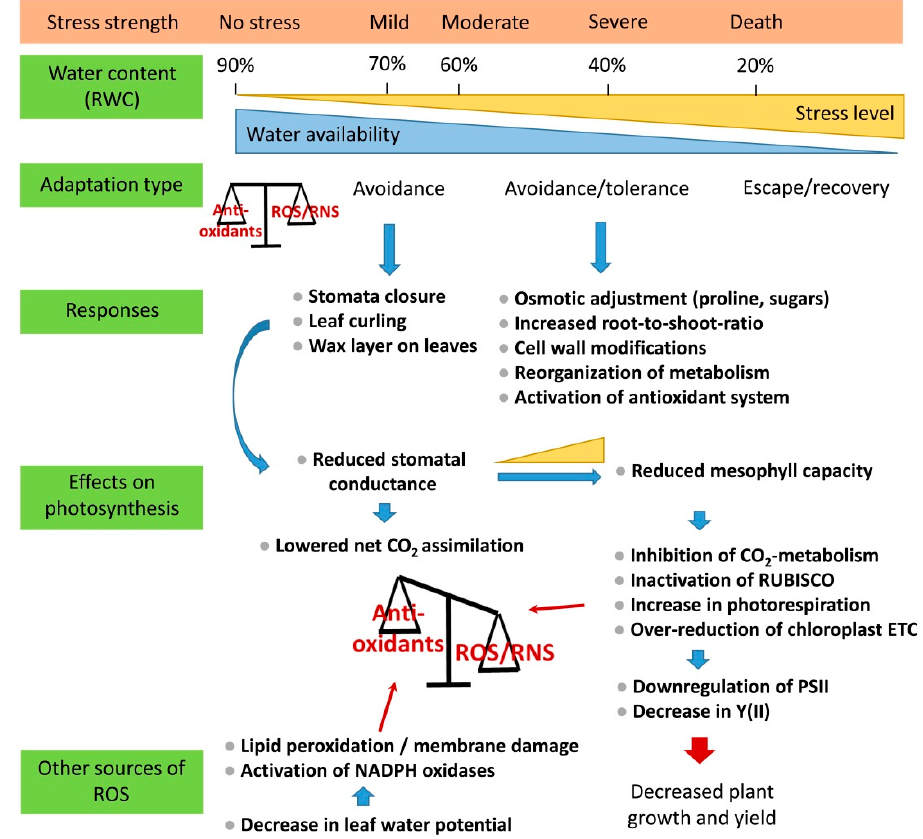
Figure 1. Physiological and biochemical processes triggered by drought.